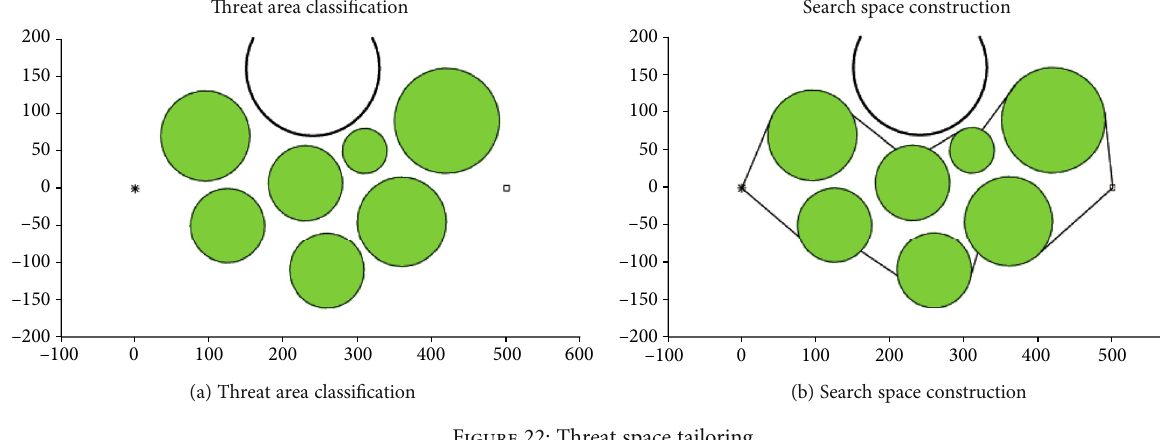
Figure 22: Threat space Table 5: Boundary docking points. Associated Associated threats